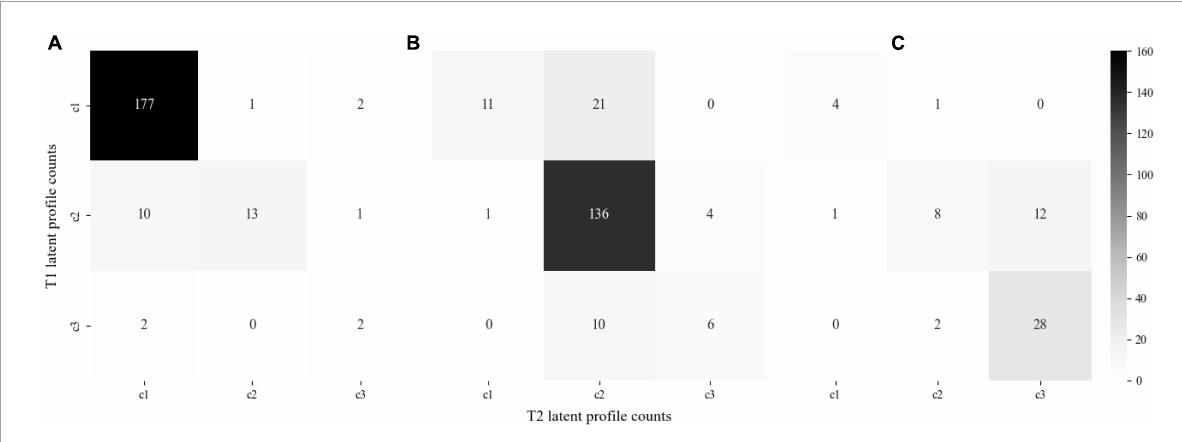
FIGURE2 The profile counts of latent profile pattern for perceived parental marital conflict and family cohesion across three time points. c1: low parental marital conflict and good family cohesion profile; c2: moderate parental marital conflict and family cohesion profile; and c3: high parental marital conflict and poor family cohesion profile. The y -axis represents T1 latent profile counts, while the x -axis indicates counts of students moving to the T2 latent profile. (A) Counts of participants moving to the c1 profile at T3; (B) counts of participants moving to the c2 profile at T3; and (C) counts of participants moving to the c3 profile at